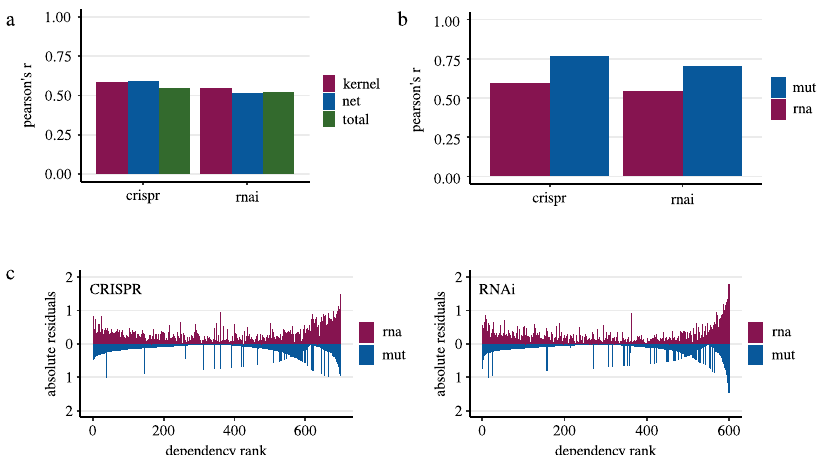
Fig. 5 Performance of mutation status-/RNA expression-based KRAS dependency models and analysis of error distributions in the complete cell line dataset. a Correlation analysis (Pearson ’ s r ) in independent test sets between the experimentally determined KRAS cancer cell line dependency and our machine learning-based predictions for varying sets of predictors (see methods). Results are shown for models using all available predictors of the RNA sequencing data (total), all available predictors of the protein interaction network (net) and predictors selected by the diffusion kernel with hyperparameter optimization (kernel). For both dependency datasets models were based on the entire cell line set (crispr - Achilles CRISPR effect data ( n = 698), rnai - DRIVE RNAi (DEMETER2) data ( n = 601). In case of diffusion kernel variable selection work fl ow maximum correlation was reached with a hyperparameter constellation using 1000 predictors. For complete results of hyperparameter tuning see Supplementary Data 4. b Correlation analysis (Pearson ’ s r ) performed similarly to ( a ) this time comparing models either using KRAS mutation status (mut) or best performing predictors of the RNA sequencing data (rna) in the respective datasets (crispr - Achilles CRISPR effect data ( n rna = 698, n mut = 704), rnai - DRIVE RNAi (DEMETER2) data ( n rna = 601, n mut = 613). Using RNA sequencing data as predictors, the best performance was achieved either with the complete protein interaction network (CRISPR) or a subset of the network consisting of 1000 genes selected by the diffusion kernel (RNAi). c Absolute error of CRISPR/RNAi models for each cell line using mutation- and best performing RNA-predictor set (CRISPR: complete protein interaction network; RNAi: diffusion kernel selection with 1000 genes). Summarized results of 400 unique models are shown in the two waterfall plots. Cell lines were ordered by ascending observed KRAS dependency from left to right. The absolute error was estimated by summing the individual absolute differences of the predicted values from the observed values (RNA expression-based (rna): purple bars; Mutation status-based (mut): blue bars). Predictions of models using mutation status show two local minima in the absolute error distributions indicating the binary prediction results. For both types of predictors residuals tend to increase at both sides of the